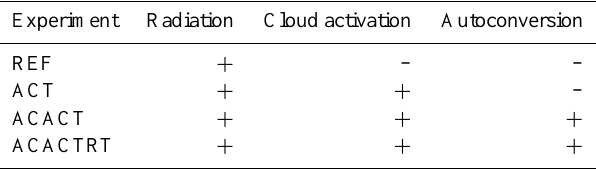
Table 1. Experimental setup indicating whether the parameterized components marked on the top row are calculated in the GCM-scale (–) or in the subcolumn-space ( +